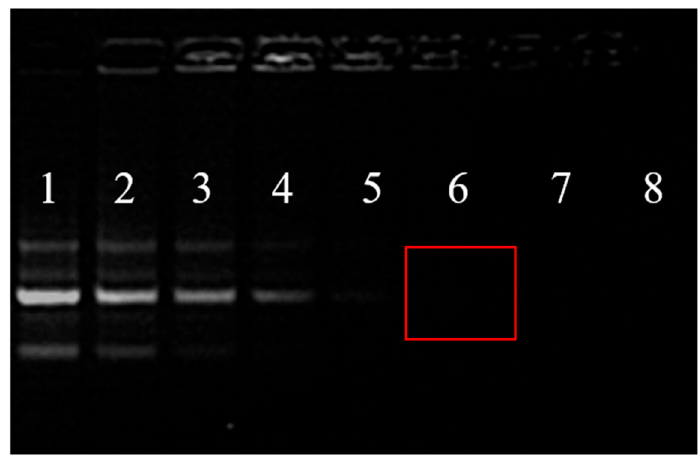
Figure 5. Agarose gel electrophoresis map of siRNA in different groups of siRNA loading. The mass of siRNA was 2 μ g, and HAp-PEI were 0, 2, 4, 8, 12, 16, 20, and 24 μ g, respectively, in 1 to 8 groups. The weight ratios of HAp-PEI and siRNA (HAp-PEI/siRNA) were 0, 1/1, 2/1, 4/1, 6/1, 8/1, 10/1, and 12/1, respectively, in 1 to 8 groups. Group 1–5: siRNA bands are gradually shallow; Red rectangular marked group 6: HAp-PEI/siRNA ( w/w ) = 8/1, siRNA band has disappeared.